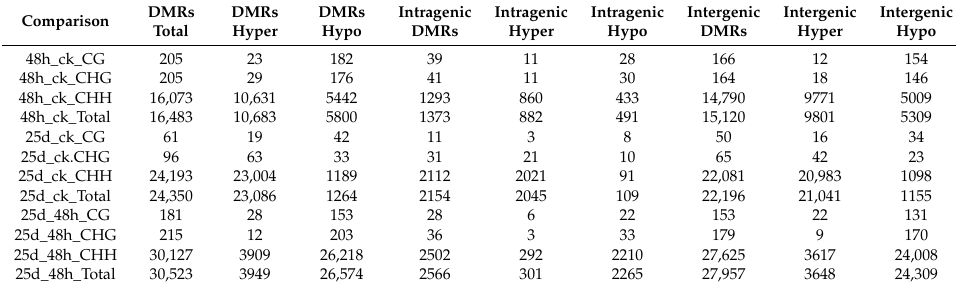
Figure 7. Number of differentially methylated regions (DMRs) identified in 48h_ck, 25d_ck, and 25d_48h. Table 2. DMRs identified in watermelon.